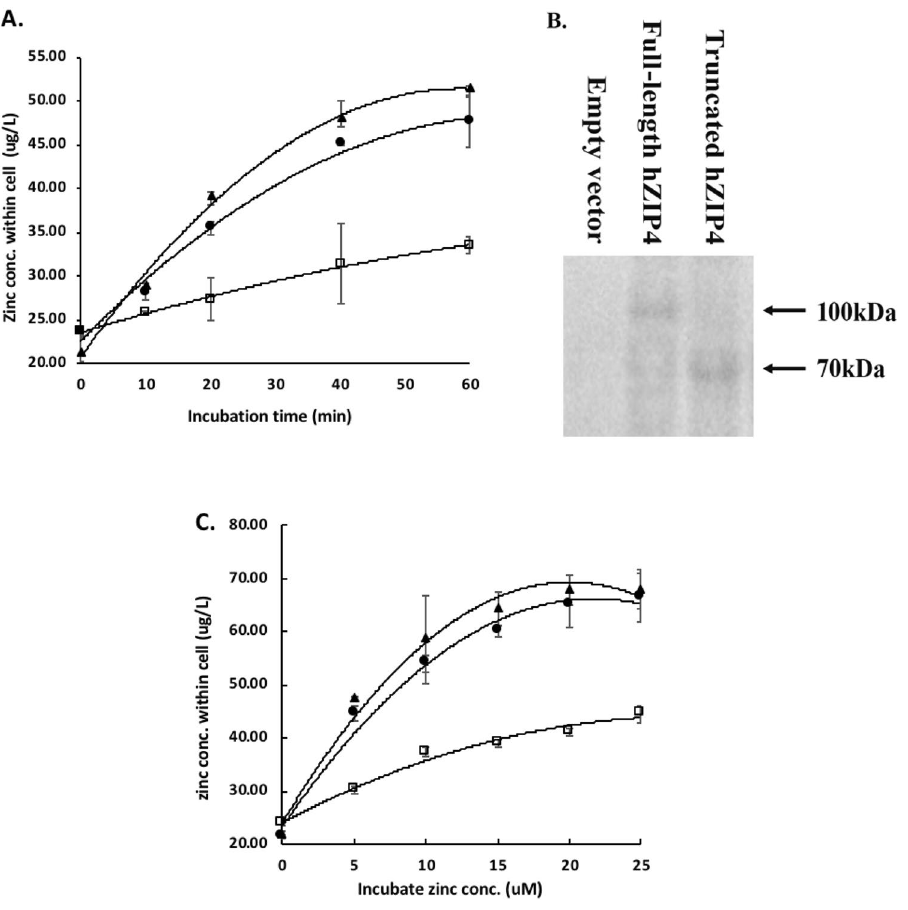
Figure 4. Kinetics of hZIP4 and truncated hZIP4 zinc transport. ( A ) Zn 2+ uptake in HEK293 cells expressed full-length hZIP4 ( ▲ ), truncated hZIP4 ( ● ), or empty vector ( □ ) as a function of time. ( B ) full-length hZIP4 and truncated hZIP4 expression level on the plasma membrane of HEK293 determined by biotinylation assay. Full-length imaging is shown in Supplement Fig. S1. ( C ) Zn 2+ uptake in HEK293 cells expressed full-length hZIP4 ( ▲ ), truncated hZIP4 ( ● ), or empty vector ( □ ) at various Zn 2+ concentrations, and the transport parameters, K m and V max of full-length hZIP4 were calculated as 3.14 ± 0.2 µM and 0.24 ± 0.01, respectively. K m and V